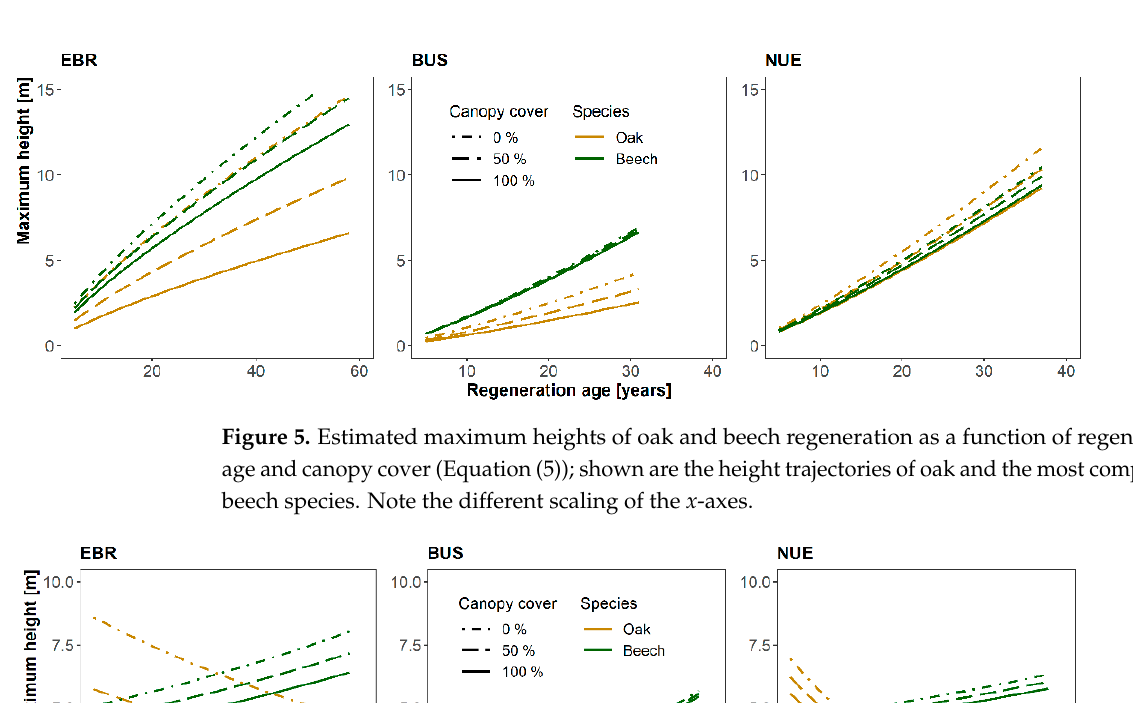
Figure 5. Estimated maximum heights of oak and beech regeneration as a function of regeneration age and canopy cover (Equation (5)); shown are the height trajectories of oak and the most competitive beech species. Note the different scaling of the x -axes.